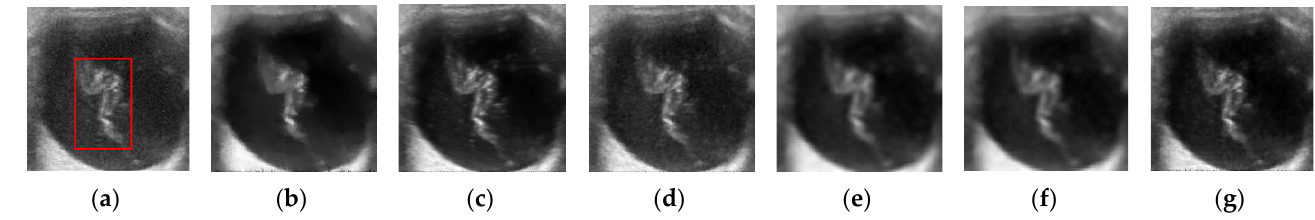
Figure 7. Denoising results of different models after adding Gaussian noise with a standard deviation of 15 to vitreous hemorrhage images. ( a ) Noise image, the red marked area is the part of the lesion. ( b ) TV model, run 0.4839 s. ( c ) FTV model, run 0.5005 s. ( d ) AFOTV model, run 0.3895 s. ( e ) F-DSG- NLM model, run 0.0747 s. ( f ) FNM model, run 14.4760 s. ( g ) Our model, run 391.6041 s.